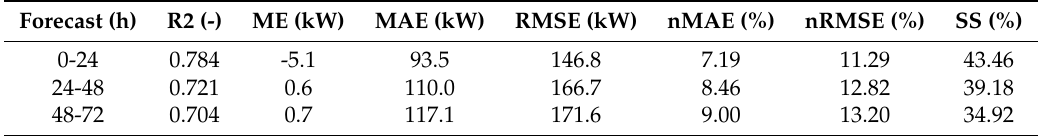
Table 6. Error measures for the deterministic forecast based on the median of the quantile ensemble probabilistic model with the IFS and EPS